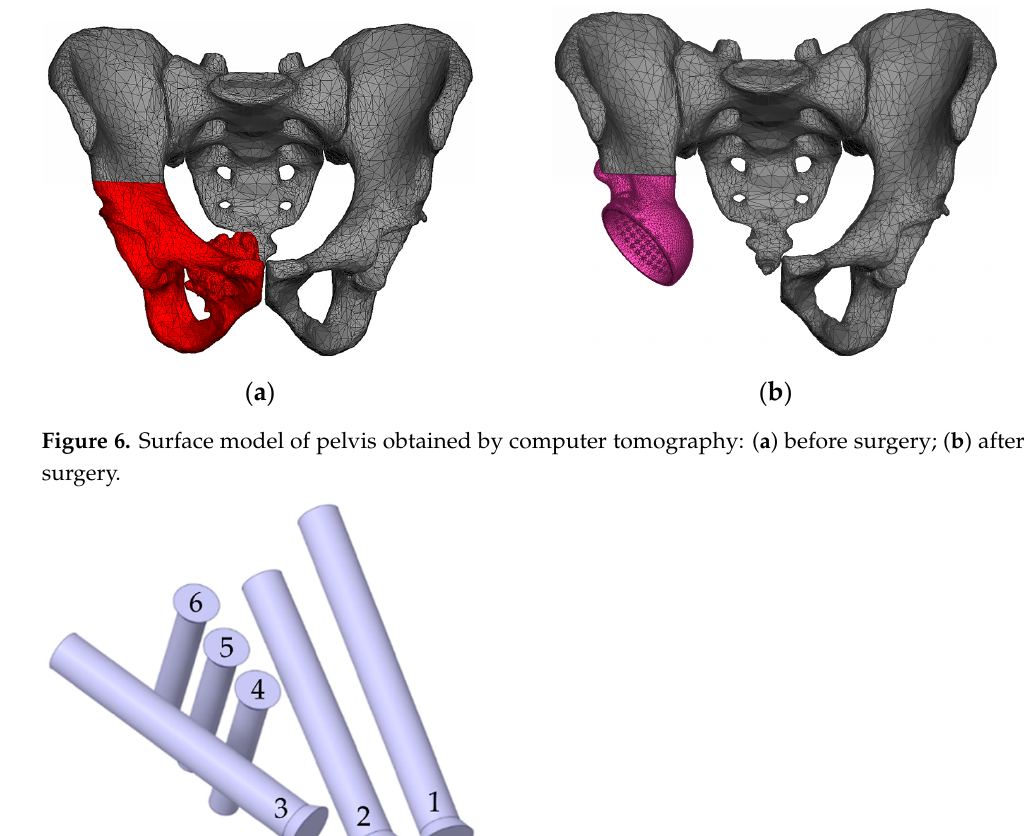
terial Designer.